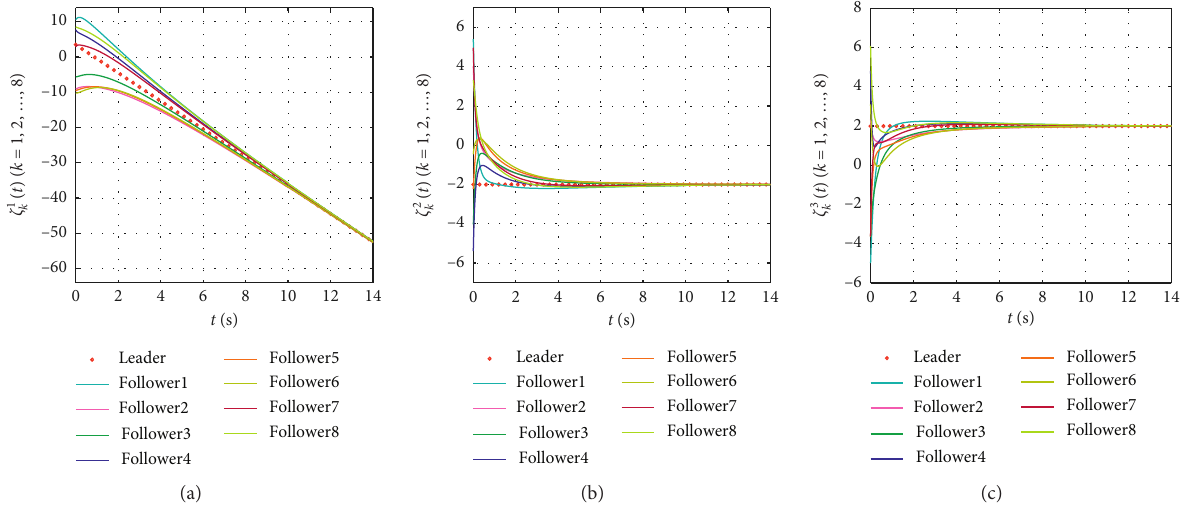
Figure 7: Trajectories of ς ( t ) , ( k � 1 , 2 , . .. , 8 ) for time-invariant formation tracking case. k